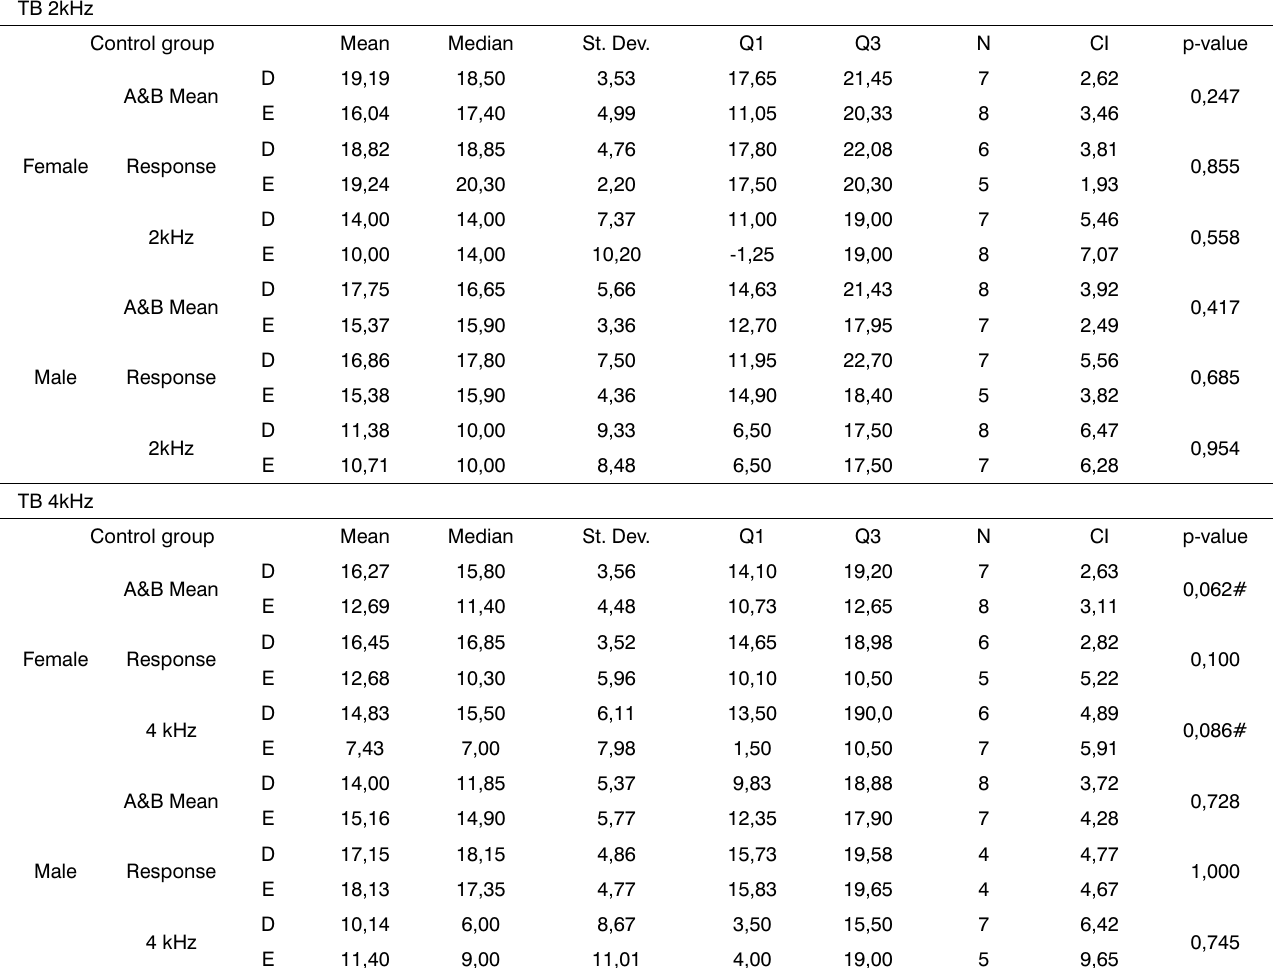
Table 2. Response magnitude (dB), descriptive analysis and comparison (p-value) between RE and LE for control group, on TB 2 kHz and TB 4